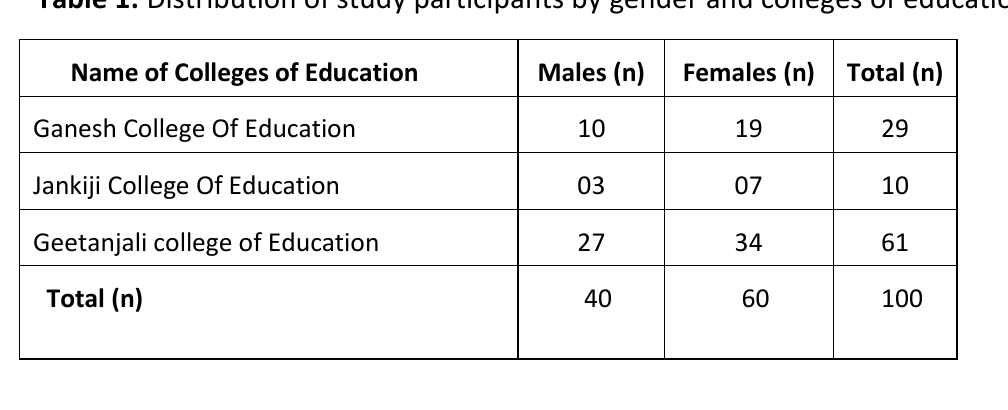
Table 1: Distribution of study participants by gender and colleges of